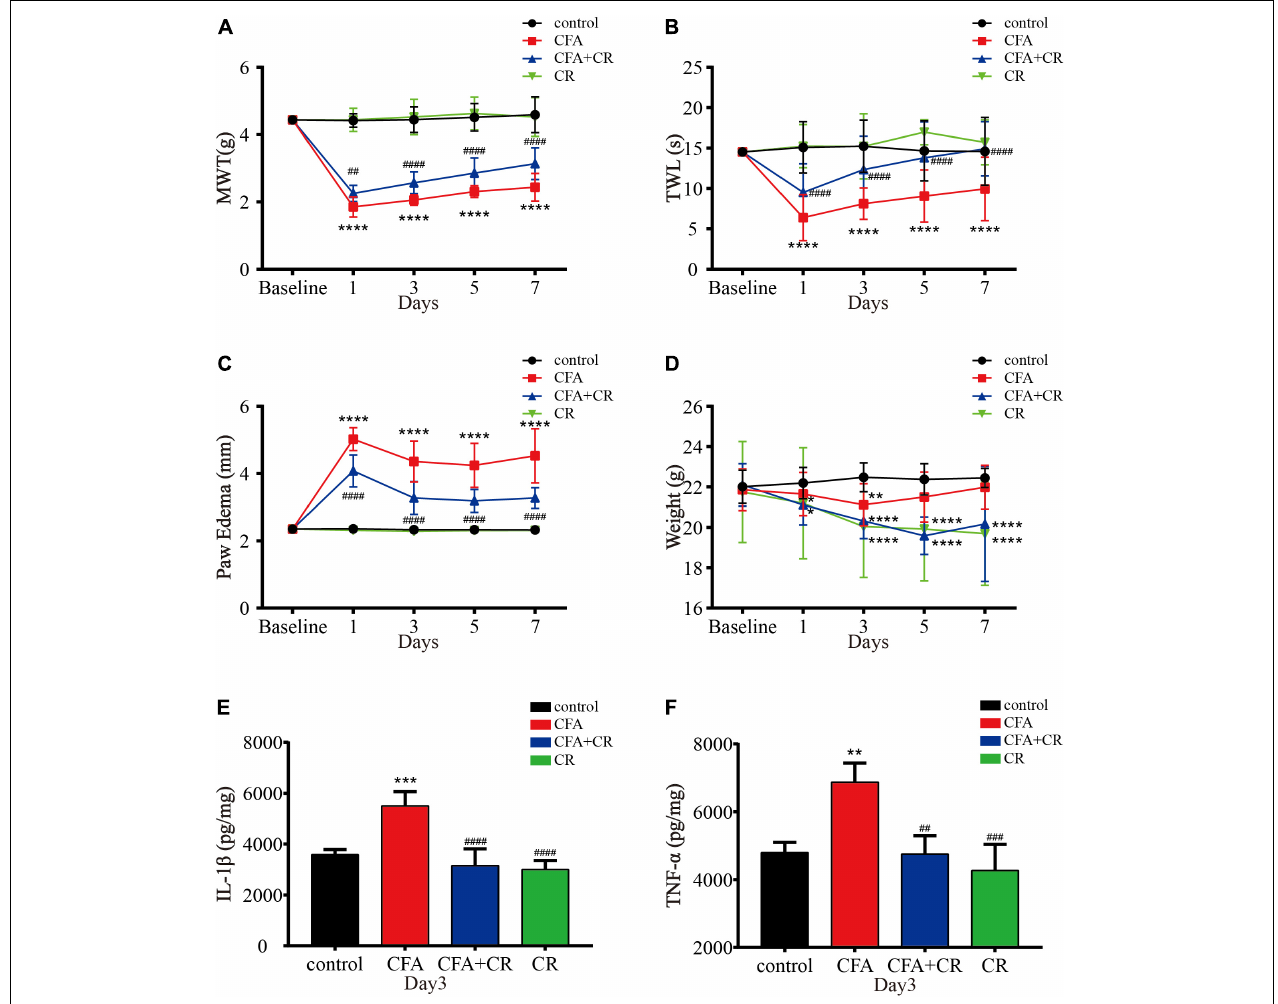
FIGURE 2 | CR attenuates CFA-induced inflammatory pain. (A) Results of the mechanical withdrawal threshold (MWT) tests anssd (B) thermal withdrawal latency (TWL) tests of mice in the control, CFA, CFA + CR, and CR groups. (C) The paw edema and (D) the Weigh tests of mice in the four groups. Values are expressed as the mean ± SD and were analyzed by two-way repeated measures analysis of variance, followed by Bonferroni post-hoc testing, n = 12 per group. ∗∗∗∗ P < 0.0001, ∗∗ P < 0.01, ∗ P < 0.05, compared to control group; #### P < 0.0001, ## P < 0.01, compared to the CFA group. (E) The level of IL-1 β and (F) the level of TNF- α were measured in the four groups. Values are expressed as the mean ± SD and were analyzed by one-way analysis of variance, followed by a Turkey’s post-hoc test, n = 4 per group. ∗∗∗ P < 0.001, ∗∗ P < 0.01, compared to control group; #### P < 0.0001, ### P < 0.001, ## P < 0.01, compared to the CFA